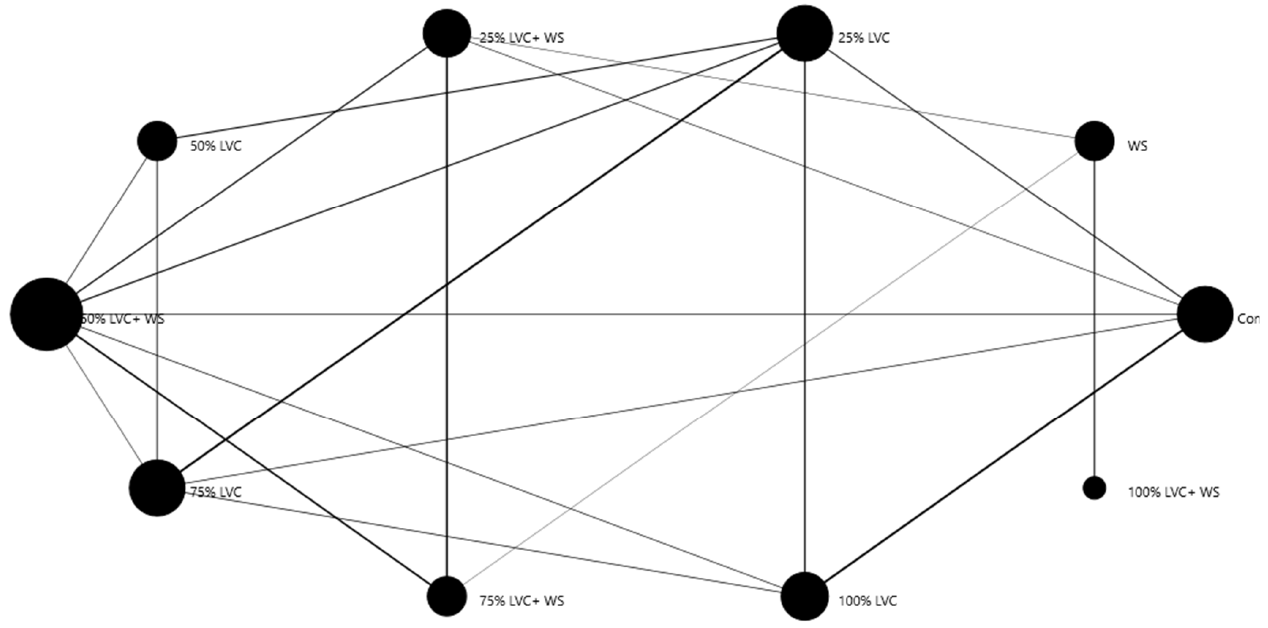
Figure 4. Network plot analysis of agronomic attributes corresponding to the treatments.